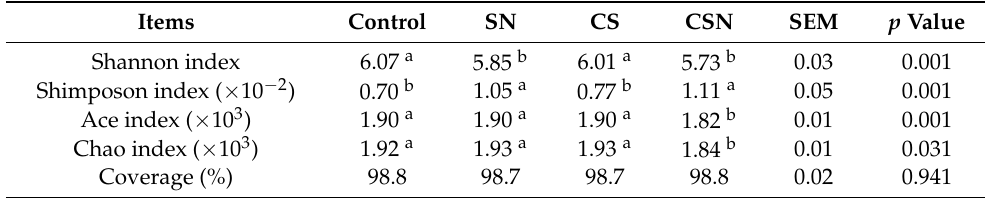
Table 6. Effects of sodium nitrate (SN), cysteamine hydrochloride(CS), and CS and SN (CSN) supplementation on bacterial alpha diversity